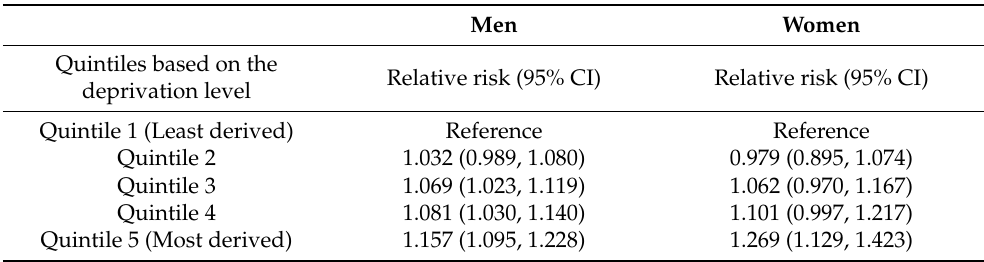
Table 4. The relative risk (and 95% CI) of esophageal cancer mortality obtained by the Bayesian spatial model. Men Women Quintiles based on the Relative risk (95% CI) Relative risk (95% CI) deprivation level Quintile 1 (Least derived) Reference Reference Quintile 2 1.032 (0.989, 1.080) 0.979 (0.895, 1.074) Quintile 3 1.069 (1.023, 1.119) 1.062 (0.970, 1.167) Quintile 4 1.081 (1.030, 1.140) 1.101 (0.997, 1.217) Quintile 5 (Most derived) 1.157 (1.095,